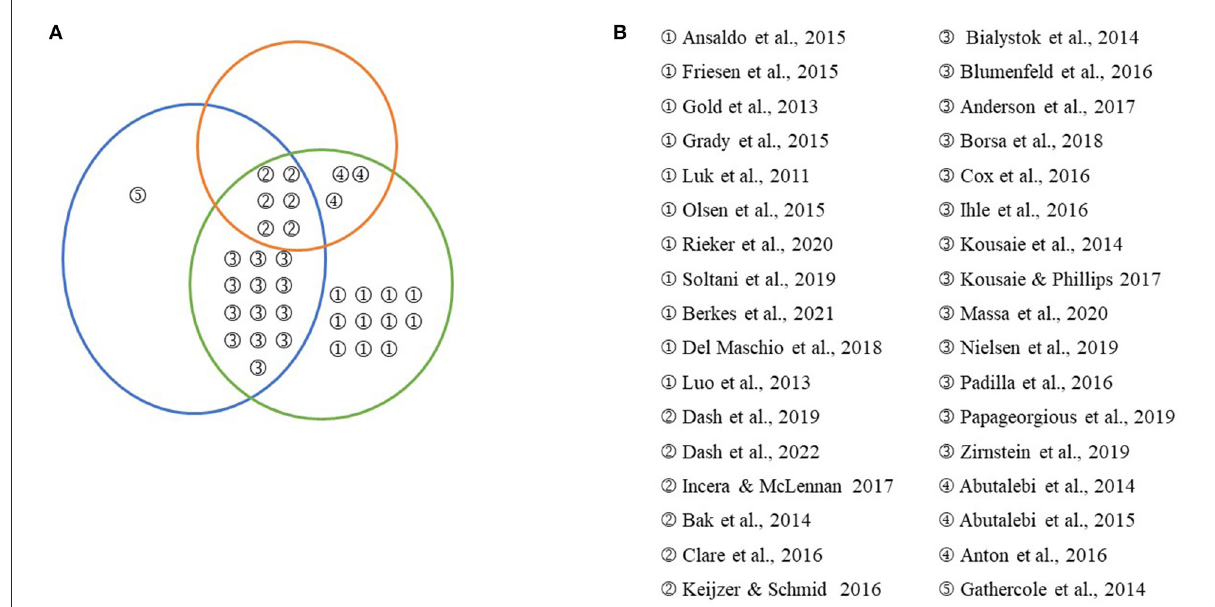
FIGURE1 (A) Venn diagram to visually group bilingual research conducted with the aging population within three categories (1) the multifactorial nature of bilingualism (in Orange), (2) the multifactorial nature of cognitive performance (in Blue), and (3) the multifactorial nature of confounding variables (in Green). (B) Numbers refer to the references shown in the corresponding